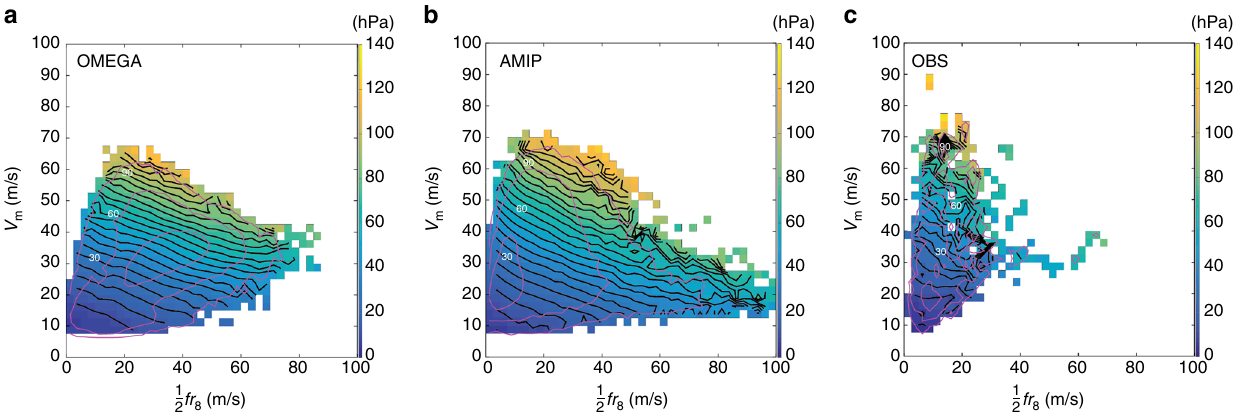
fr 8 ) across simulations and observations. a OMEGA; binned MLR 2 (cid:1) (cid:3) fr ( r 2 ¼ 0 : 92 ; N bin ¼ 281 ; ϵ RMS ¼ 7 : 8 hPa ). Data are binned into 2.5 ms − 1 8 2